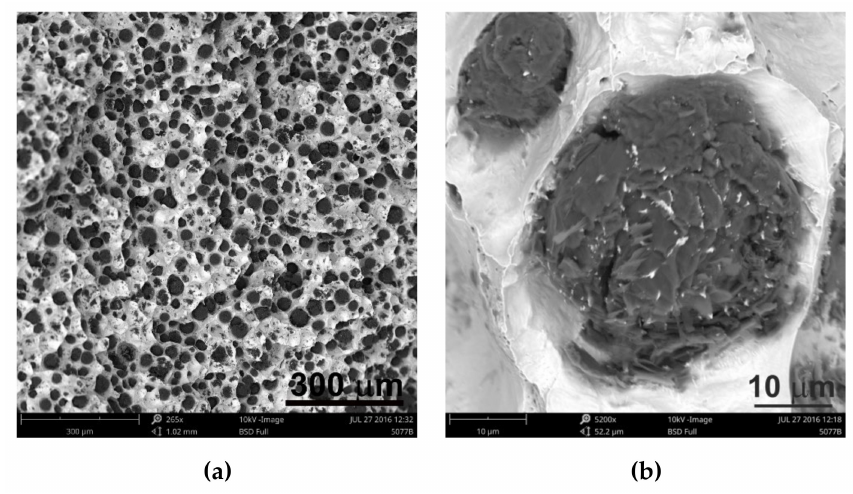
Figure 8. Images of sample fractures 10 magnification 265x (a) and 5200x